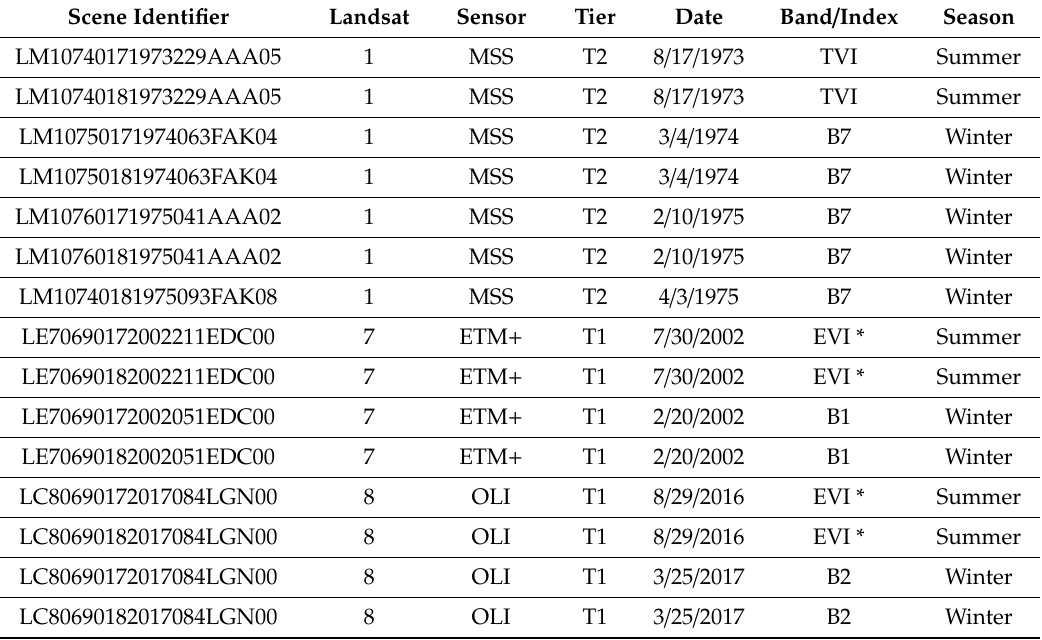
Table 1. Landsat scenes used in this